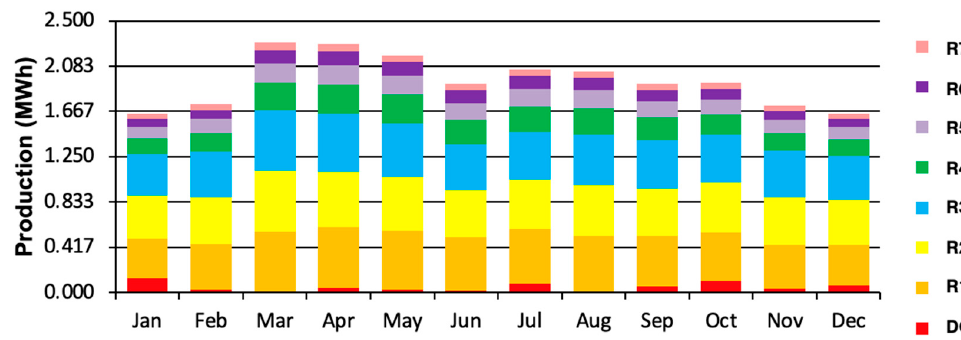
Figure 17. Monthly electricity production of the OSC at 37.9 kWh/day.